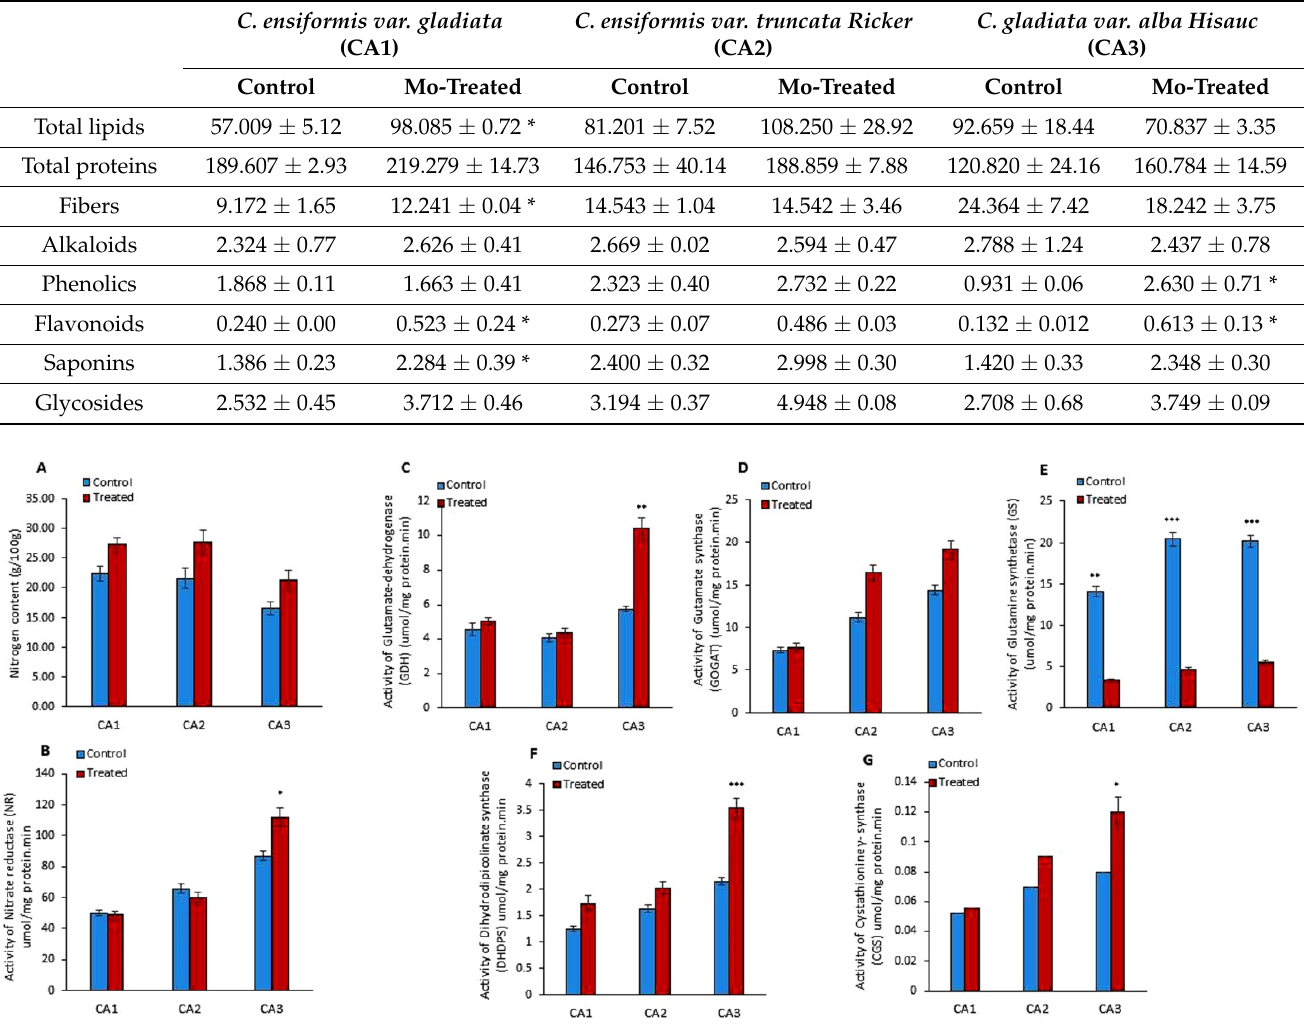
Figure 2. Effects of molybdenum (Mo) treatment on nitrogen assimilation. ( A ): Nitrogen (N) content (g/100gFW). ( B ): Nitrate reductase (umol/mg protein. min) activity. ( C ): Glutamte dehydrogenase (GDH) activity ( µ mol/mg protein. min). ( D ): Gutamate synthase (GOGAT) activity ( µ mol/mg protein. min). ( E ): Glutamine synthetase (GS) activity ( µ mol/mg protein. min). ( F ): Dihydrodipicolinate synthase (DHDPS) activity ( µ mol/mg protein. min). ( G ): Cystathionine γ - synthase (CGS) activity ( µ mol/mg protein. min). Control; without treatment, Treated; Mo treatment. CA1; Canavalia ensiformis